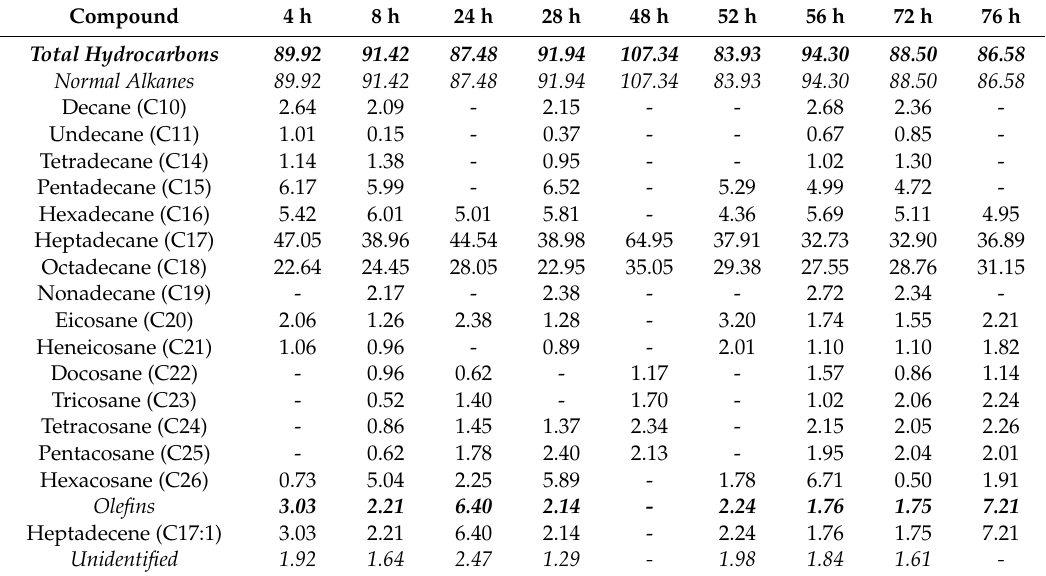
Table A2. GC-MS analysis of the liquid products from the catalytic upgrading of used cooking oil (75 wt.% in C12) over 20% Ni–5% Cu / Al 2 O 3 at 375 ◦ C and WHSV = 1.0 h − 1 , in 100% H 2 . Text in bold corresponds to compound classes comprising the individual compounds listed. Text in italics corresponds to compound sub-classes comprising the individual compounds detected. Values shown are wt.%.